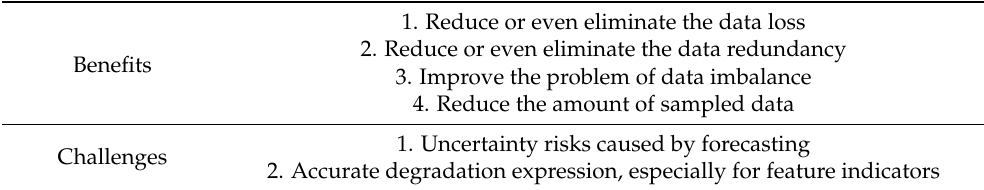
Table 6. The benefits and challenges of the proposed